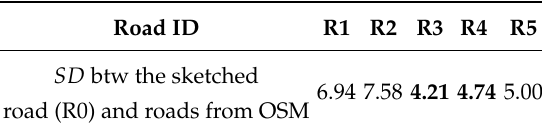
Table 1. SD between R0 and R1–R5. Note that 4.21 and 4.74 are in bold because R3 and R4 have the smaller SD w.r.t. R0.